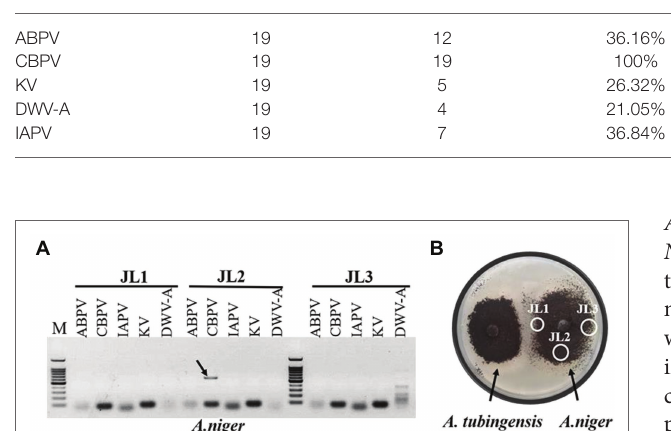
Honey bee viruses